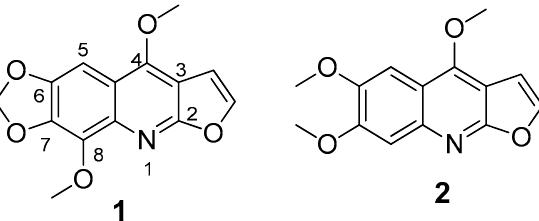
Figure 1. Furoquinoline alkaloids, flindersiamine 1 , and kokusaginine 2 , isolated from leaves of E. alata .